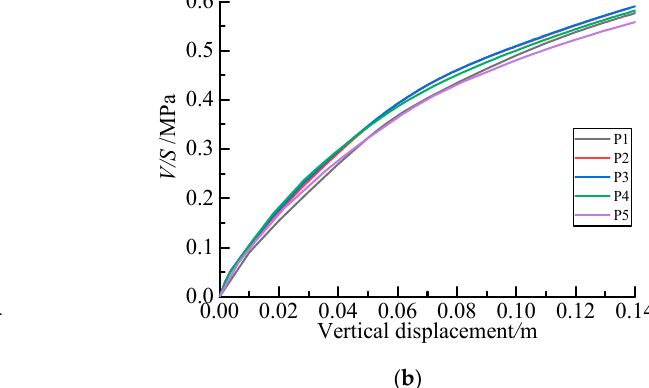
Figure 17. Uplift bearing characteristics of helical pile with different pitches. ( a ) Load-displace- ment curves; ( b ) V/S -displacement curves.